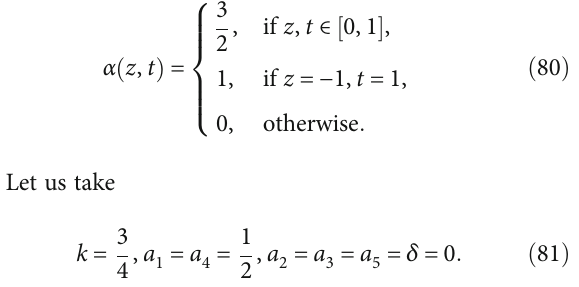
ffiffiffiffiffiffiffiffiffiffiffiffiffiffiffi z 2 − t 2 j ffiffiffiffiffiffiffiffiffiffiffiffiffiffiffiffiffi z